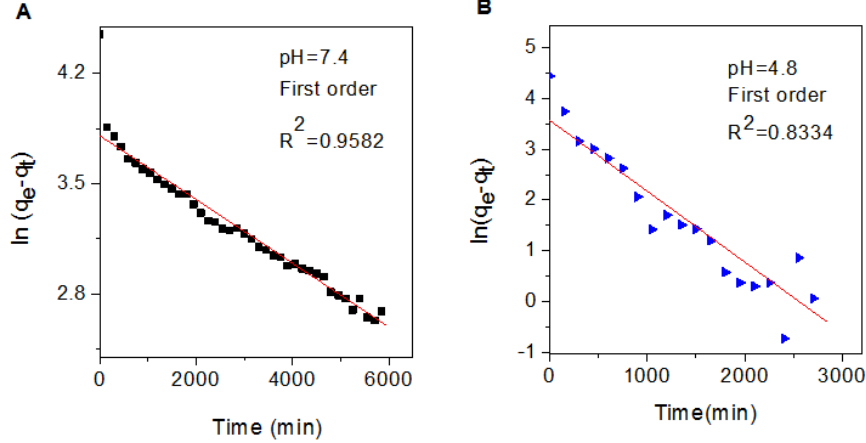
Figure 7. Kinetics of controlled release by fitting the data of perindopril erbumine release from iron oxide nanoparticles coated with chitosan-prindopril erbumine (FCPE) into phosphate-buffered solutions at pH 7.4 ( A ) and pH 4.8 ( B ) using first-order kinetics